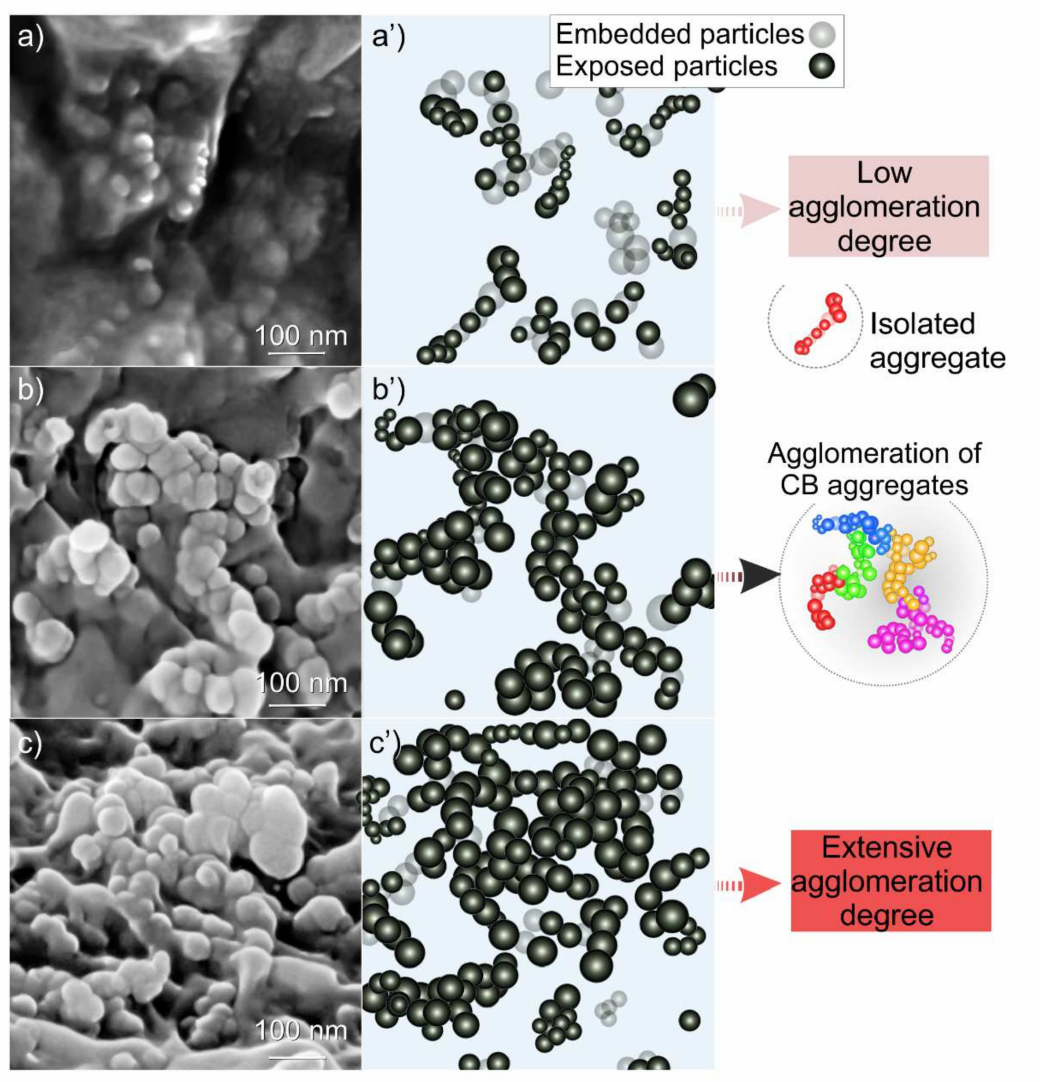
Figure 3. High-resolution FESEM images of CB-reinforced PA66 melt compounded composites with different filler content: 14 % ( a ), 17 ( b ), 21 wt. % ( c ), and the associated schematic representations illustrating the CB particles, their aggregates at the different filler loadings: 14 ( a’ ), 17 ( b’ ), and 21 wt. % ( c’ );